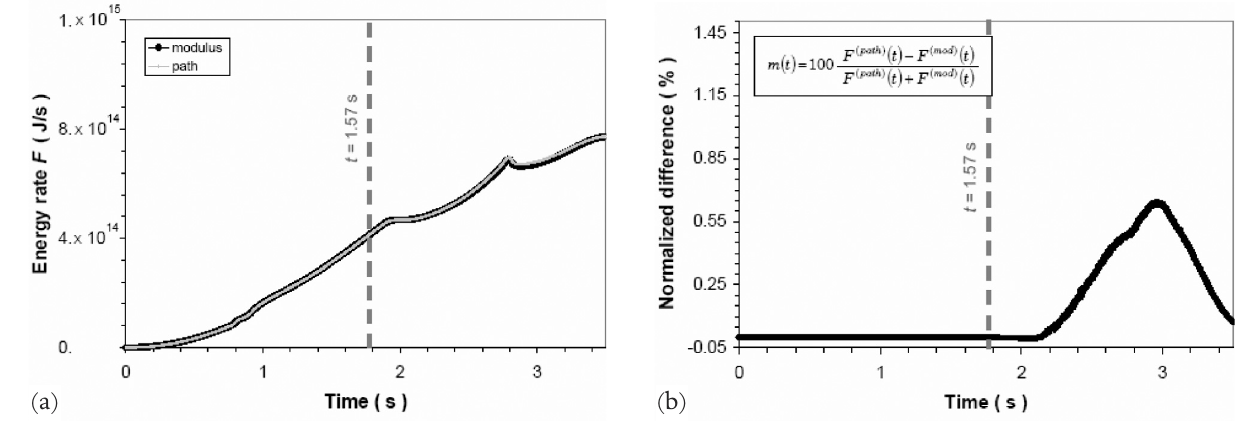
Figure 4. (a) Time evolution of the energy flux F for the two models ( F is computed from Equation (8) of Bizzarri [2013]). As for Figure 3 the thick black lines refer to the formulation (1), while the thin gray lines refer to the formulation (2). (b) Normalized difference between F from the two models; namely, in the ordinate axis we plot, for each time t , the misfit ( * ). In both the panels the vertical dashed gray line in- dicates the first time when the supershear transition occurs.